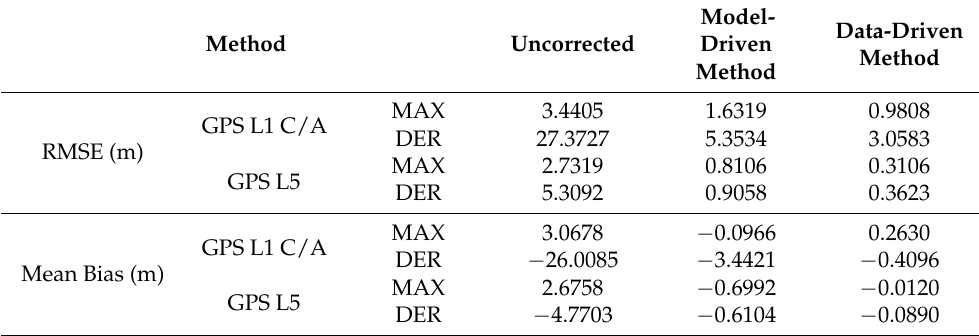
Table 1. Altimetry precision obtained using different correction methods for different signals and types of characteristic